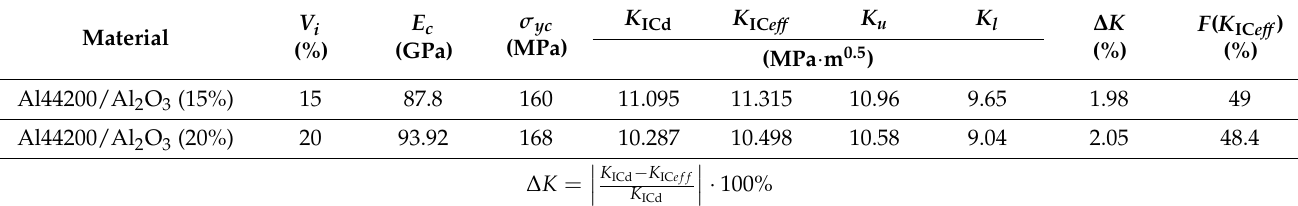
Table 3. Material properties of the Al44200/Al 2 O 3